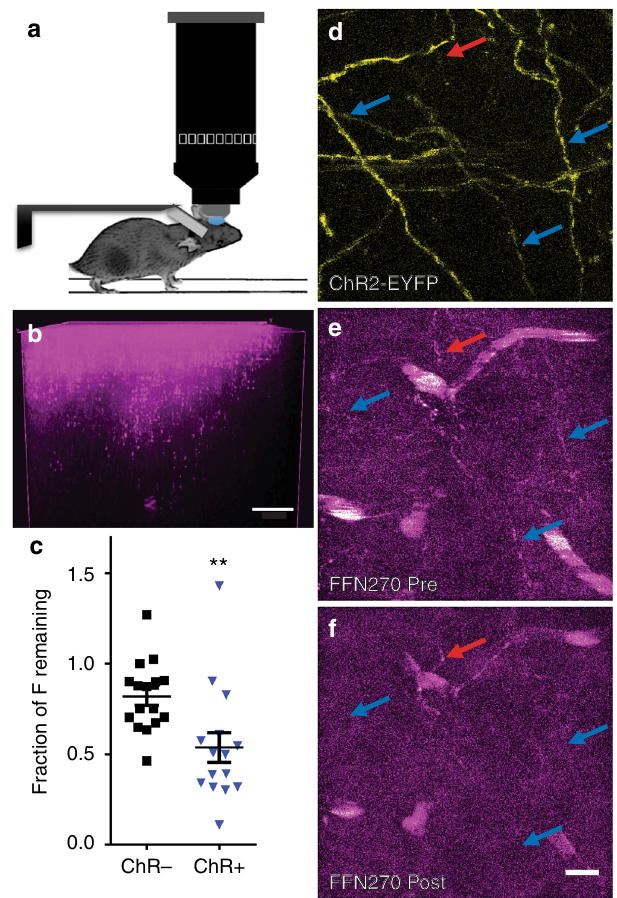
Fig. 6 Examining NE axons and release sites in living animals. a Representative in vivo setup using an anesthetized head- fi xed animal to image Layer 1 of the barrel cortex. b A representative 3D reconstruction of FFN270 labeling (50 µ M locally applied) in Layer 1 of the barrel cortex in vivo. Scale Bar: 20 µ m. c FFN270 loaded into NE axons with ChR2, as described in Fig. 5, can be released with local 470 nm light stimulation (10 Hz, 2400 pulses). There is a signi fi cant increase in FFN270 released from axons that colocalize with ChR2 (ChR + , 46.2 ± 8.3%, highlighted with blue arrows) compared to axons that do not (ChR – , 18.13 ± 4.8%, highlighted with a red arrow, n = 6 animals, P = 0.0012, Mann – Whitney). Representative images of the ChR2-YFP signal ( d ), and the FFN270 signal before ( e ) and after ( f ) optogenetic stimulation. All data listed as mean ± SEM. Scale bar: 10 µ